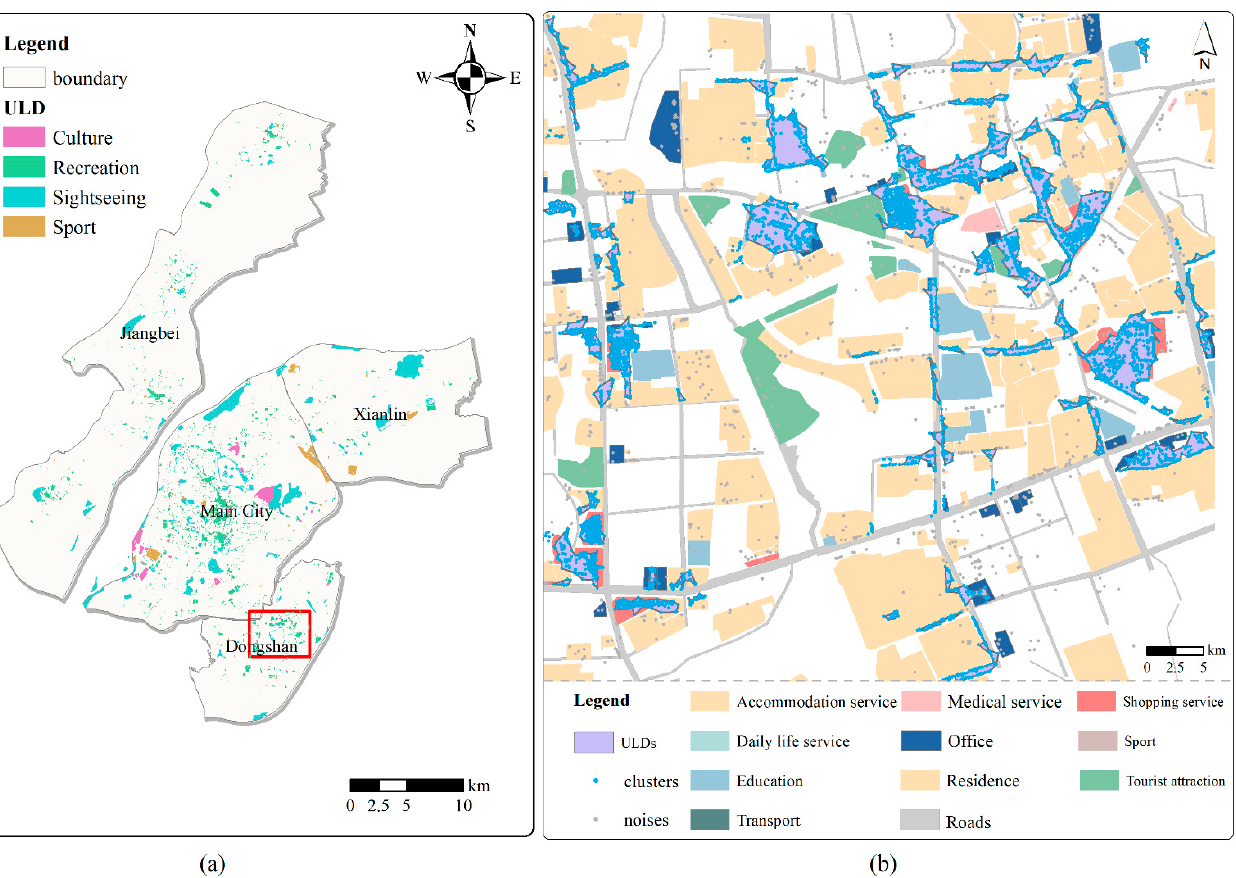
Figure 4. Recognition results of the ULDs in Nanjing ( a ) and the implementation details of the ULD recognition method in the selected sample region ( b ), which is the magnification of the red frame in ( a ). ( b ) shows the ULDs generated by leisure POI clusters, and the leisure area near the residence was successfully identified.